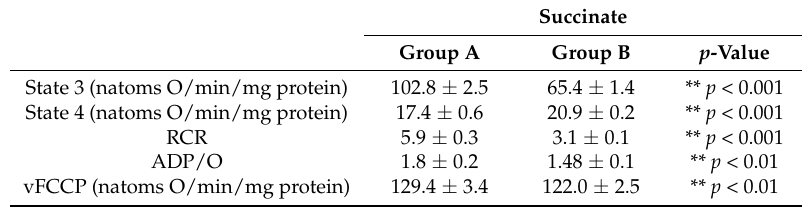
Table 2. The effects of I/R with or without BBR (18.6 mM) supplementation on hepatic mitochondrial respiration. Mitochondria were isolated from animals sacrificed after 12 h of hepatic exposure to preservation solution and 1 h of reperfusion, as described in the Materials and Methods Section. Control animals were sham operated. Oxygen consumption was polarographically evaluated with a Clark-type oxygen-sensitive electrode. Mitochondria isolated from the I/R group (Group B) had a clear loss of respiratory capacity compared to the group supplemented with BBR (Group A). Data are the means ± SEM of at least 2 different experiments, performed with 10 animals/group. Statistical significance p < 0.05; ** indicates a statistically-significant difference ( p < 0.01) between Groups A and B. RCR, respiratory control ratio.